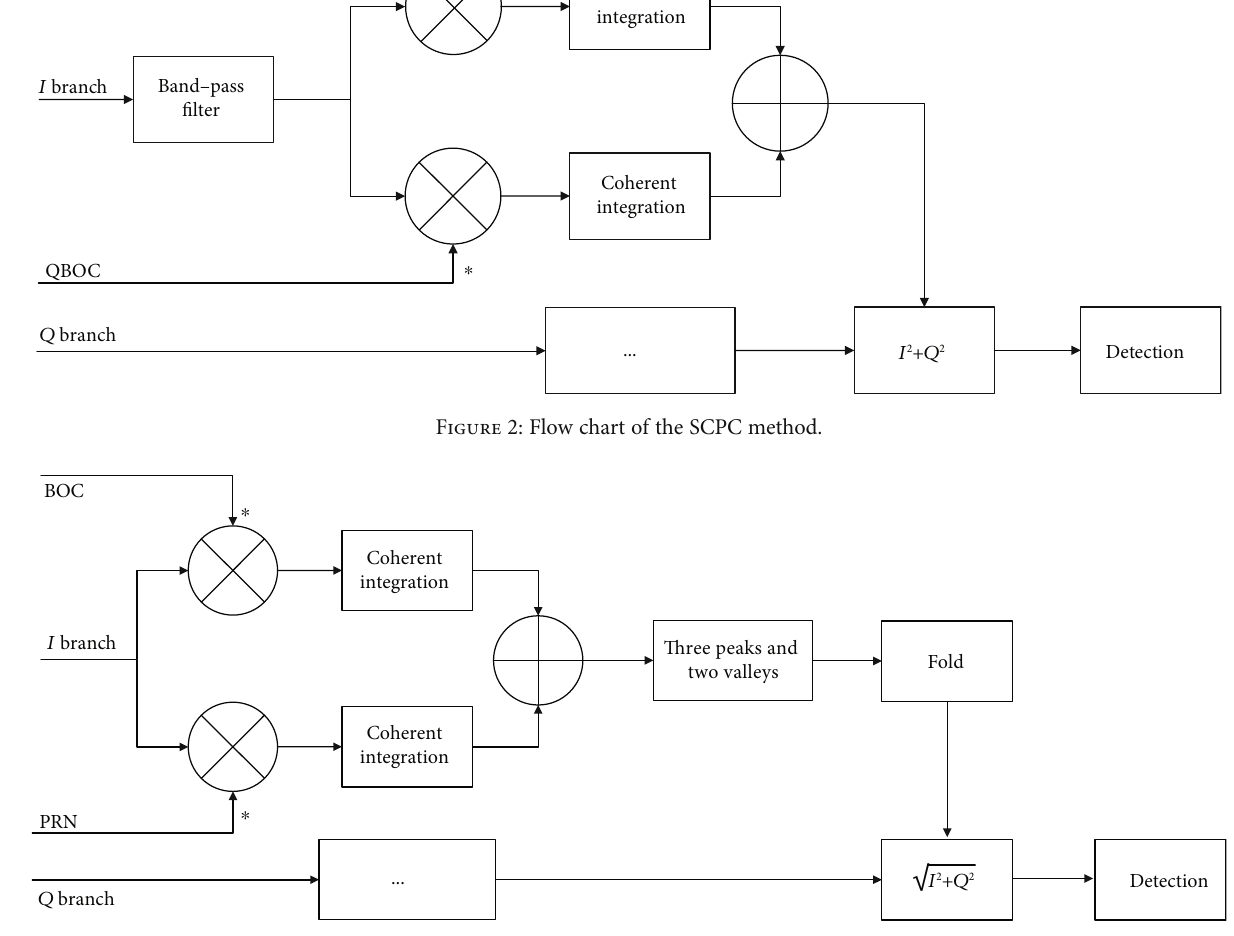
Figure 3: Flow chart of the RZCC